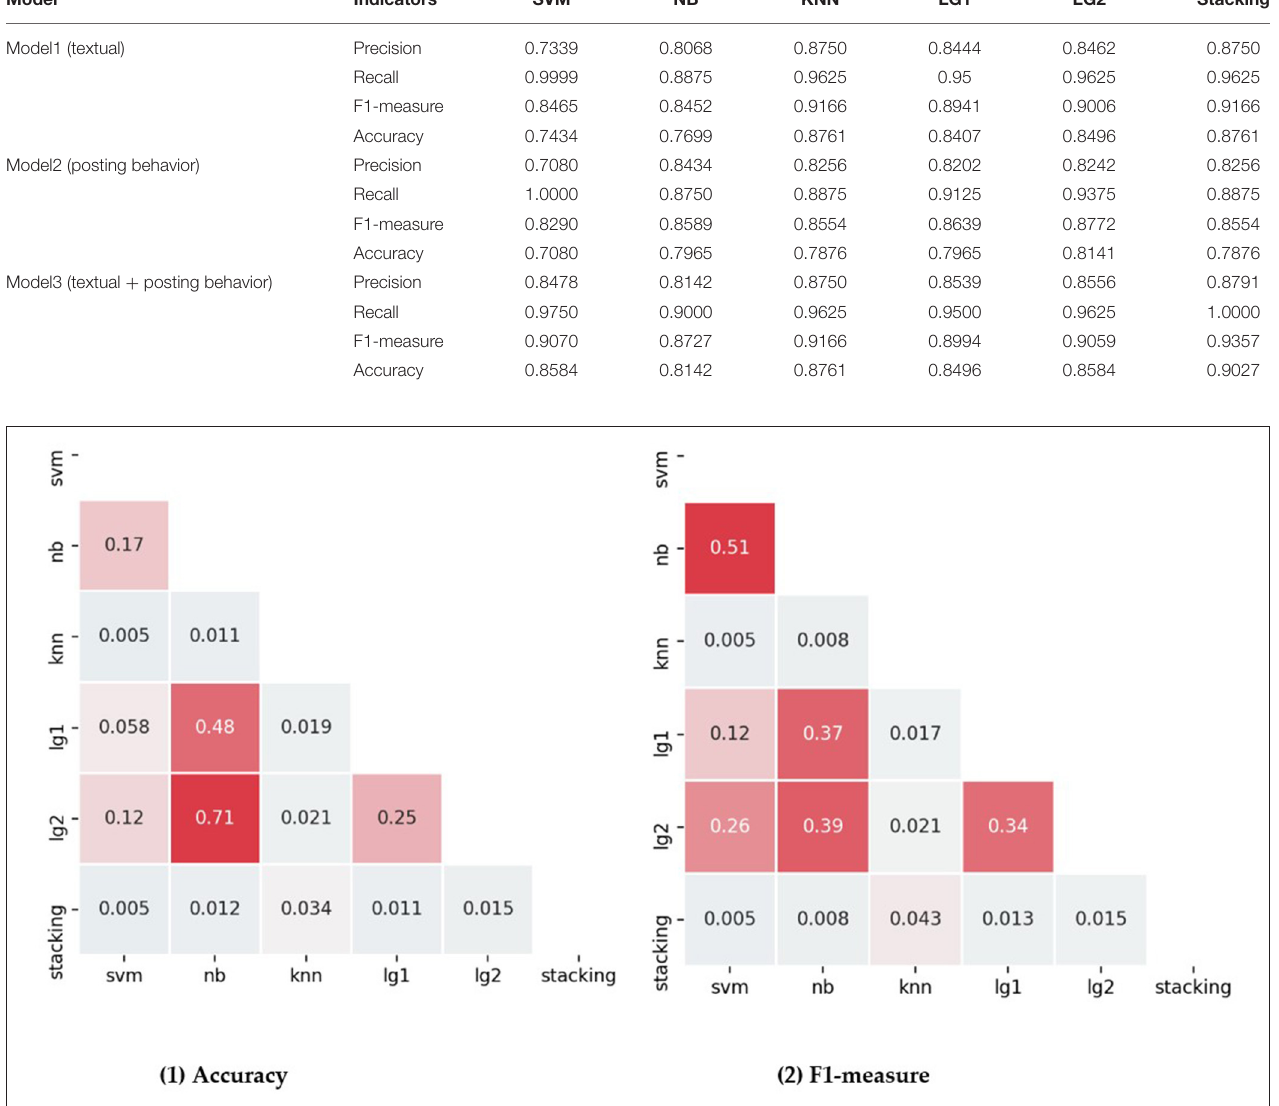
TABLE 3 | Performance measurements of each method on different models.